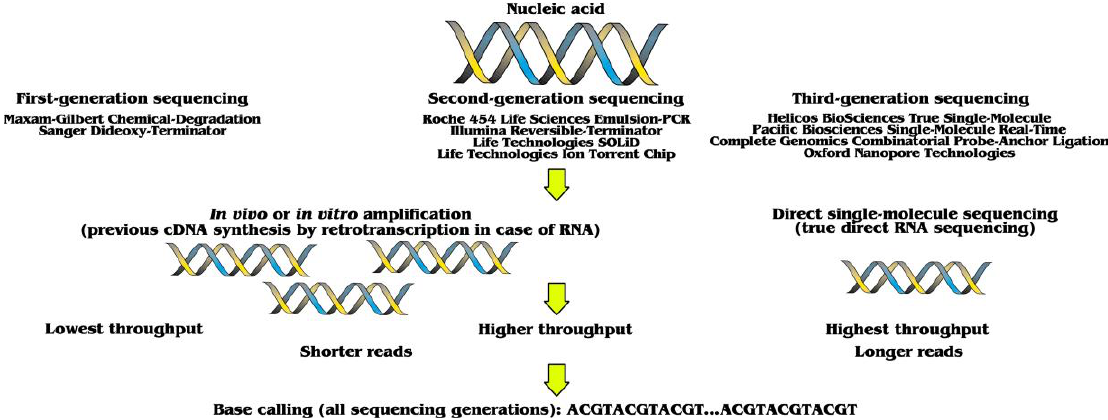
Figure 1. Comparison of sequencing platforms. FGS allows to sequence small fragments of DNA. SGS represents a significant increase in throughput. Finally, besides generating much longer reads, TGS can sequence single molecules without previous RNA retrotranscription or DNA amplification. Such a breakthrough allows to directly sequence